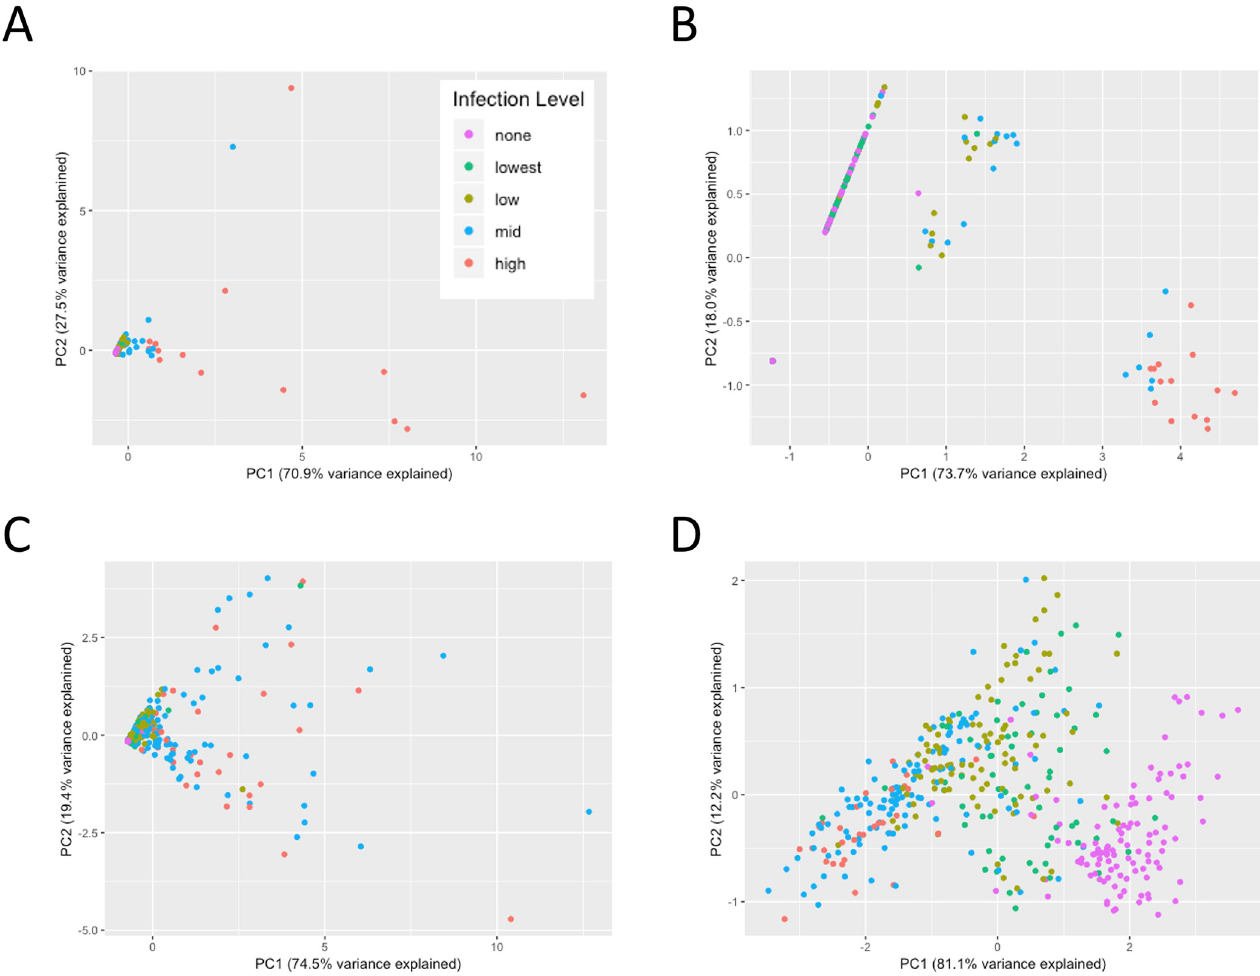
Fig 4. Principal components analysis of HRP2, pLDH, and pAldolase concentrations and log concentrations for infection level using qPCR. Infection level categories: None = 0 parasites/ μ L; Very low = > 0–20; Low = > 20–200; Mid = > 200–2,000; High = > 2,000. A) Angola (sen-qPCR). B) Angola (sen- qPCR), log scale. C) Haiti (PET-PCR). D) Haiti (PET-PCR), log scale.